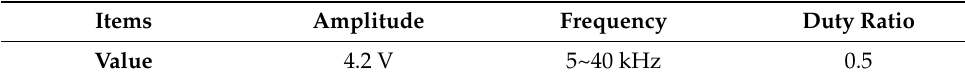
Table 2. Parameters of pulse waveform for driving the PZT tube. Items